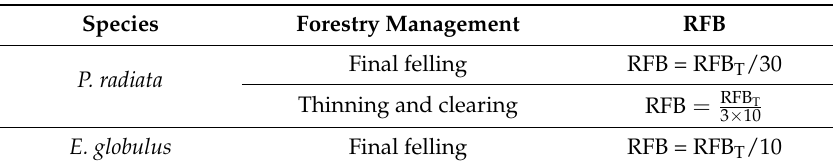
Table 5. Total RFB (Mg year − 1